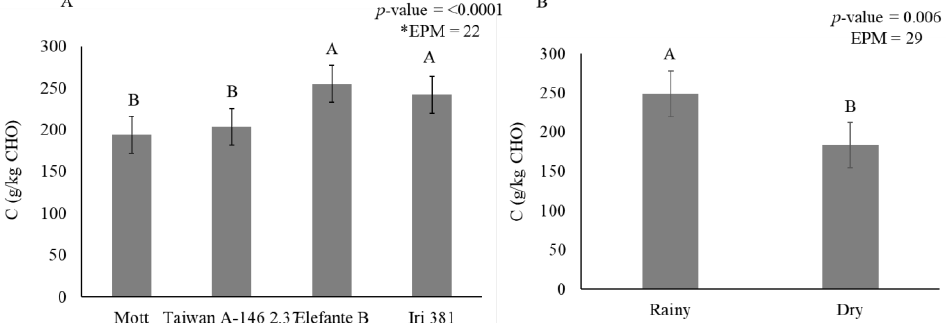
Figure 5. Stem carbohydrate fraction C (g/kg carbohydrate) as affected by genotype ( A ) and season ( B ) for elephantgrass genotypes at Garanhuns, Pernambuco, Brazil. *EPM = Standard error of the means. Mott (193 g/kg CHO) and Taiwan A-146 2.37 (203 g/kg CHO) contained a lower indigest- ible carbohydrate fraction than Elefante B (254 g/kg CHO) and Iri 381 (242 g/kg CHO) (Figure